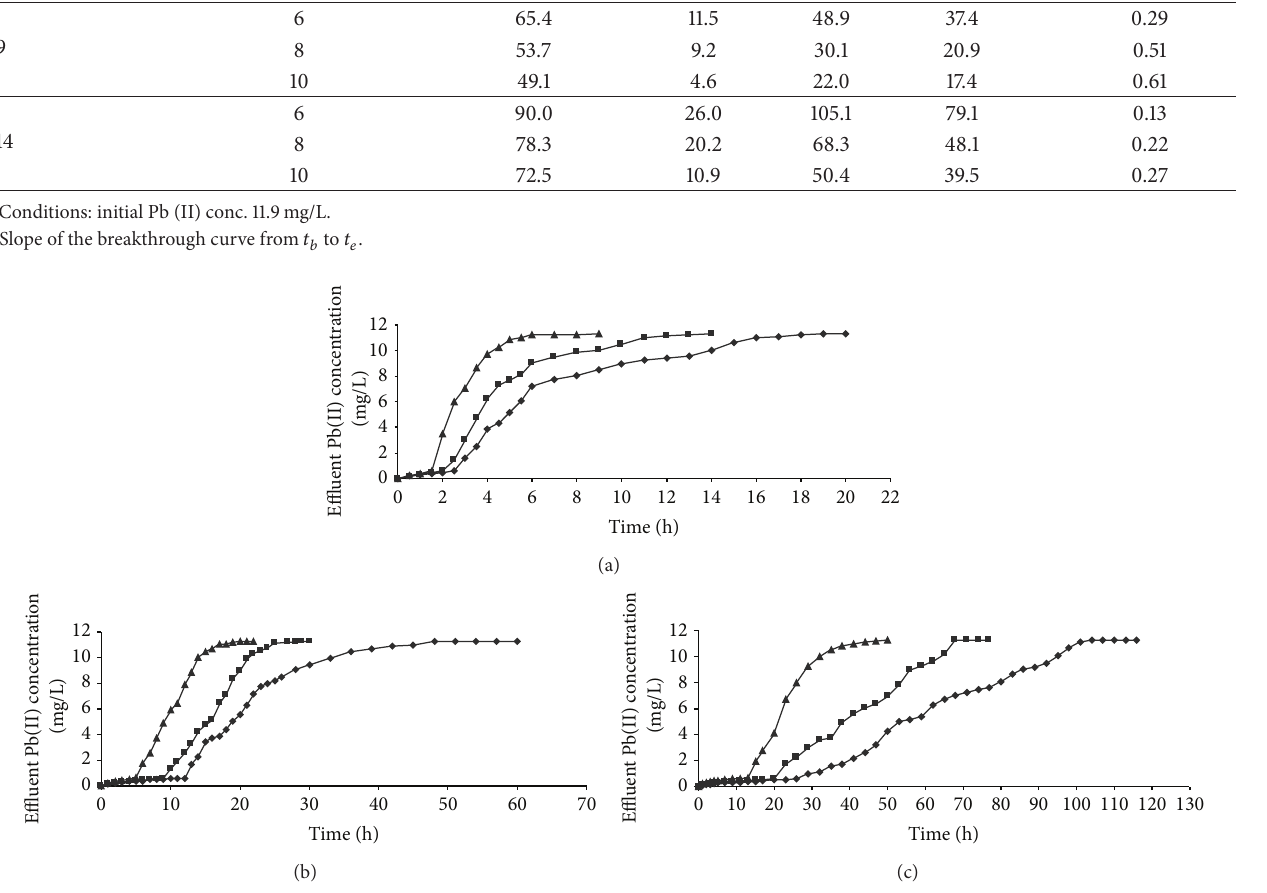
Figure 4: Breakthrough curves at different flow rates obtained for [poly(EGDMA-VIM)]. (a) Bed height 5cm, (b) bed height 9cm, and (c) bed height 14cm. Conditions: initial Pb(II) conc. = 11.9mg/L; pH 9.4 flow rate: ( Q ) 6mL/min; ( ◼ ) 8 mL/min; ( 󳵳 )